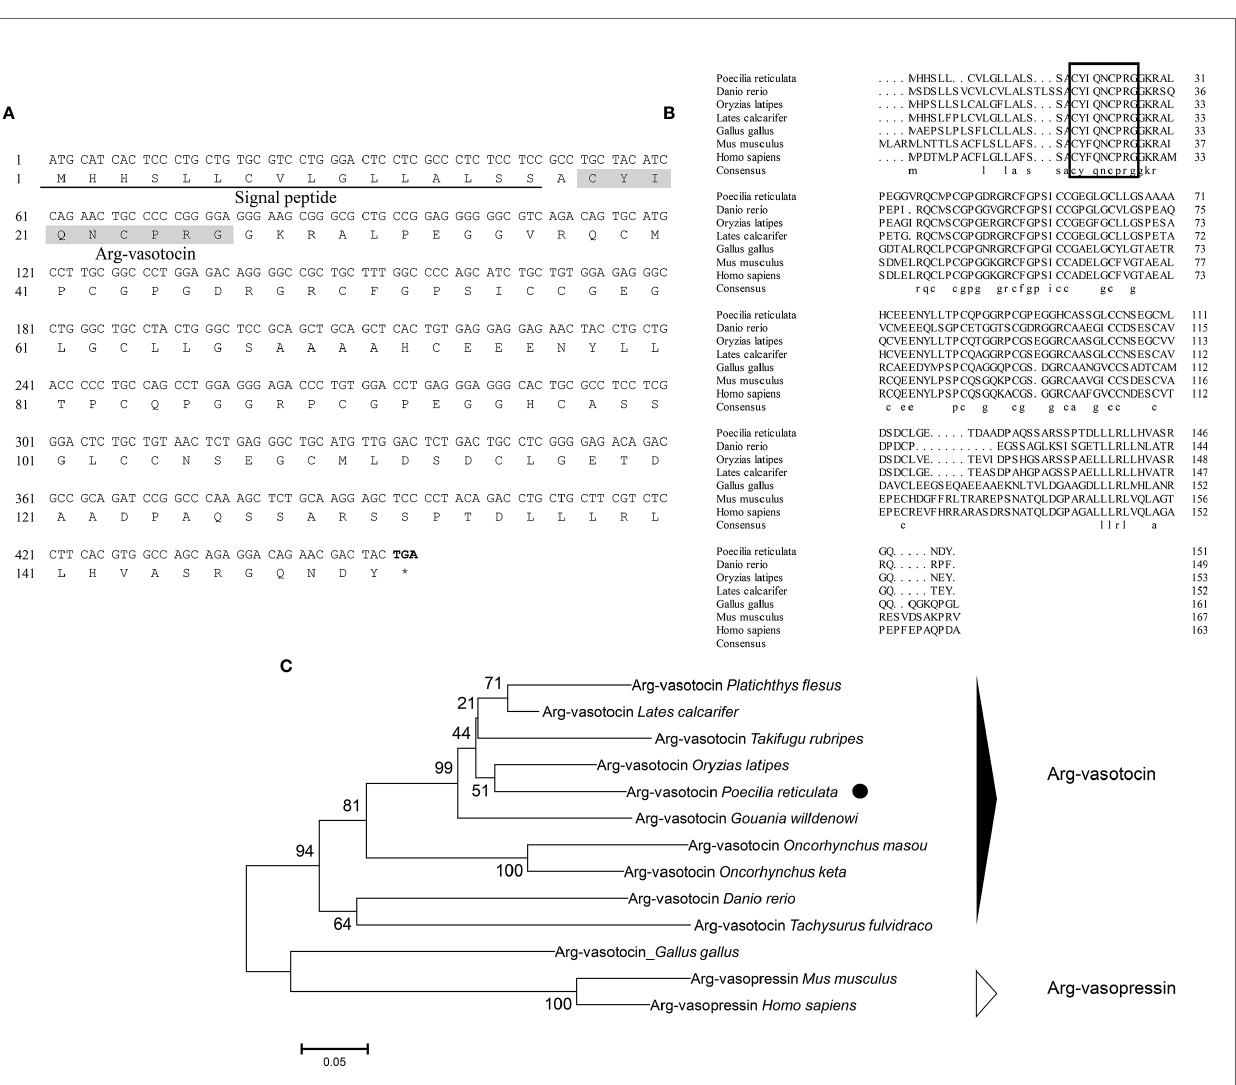
FIGURE 1 | (A) Nucleotide and deduced amino acid sequences of guppy AVT. The putative signal peptide is underlined. The putative AVT peptide is shaded. (B) Multiple comparisons of amino acid sequences of AVP/AVT precursors. The boxed letters indicate the sequence of mature AVP/AVT. (C) Phylogenetic analysis of AVP/AVT precursors in different species. Phylogenetic tree was constructed using MEGA 6 software and the neighbor-joining method. The data were resampled with 1,000 bootstrap replicates. The accession numbers of each sequence are as follows: Oryzias latipes (BAM15897.1), Lates calcatifer (XM_018674883.1), Takifugu rubripes (AAC60293.1), Danio renio (NP_840078.1), Homo sapiens (AAA61291.1), Gallus gallus (NP_990516.1), Mus musculus (AAC42027.1), Tachysurus fulvidraco (XM_027167236), Oncorhynchus masou (AAC60743.1), Oncorhynchus keta (CAA35205.1), Platichthys fl esus (BAA98140.1), and Gouania willdenowi